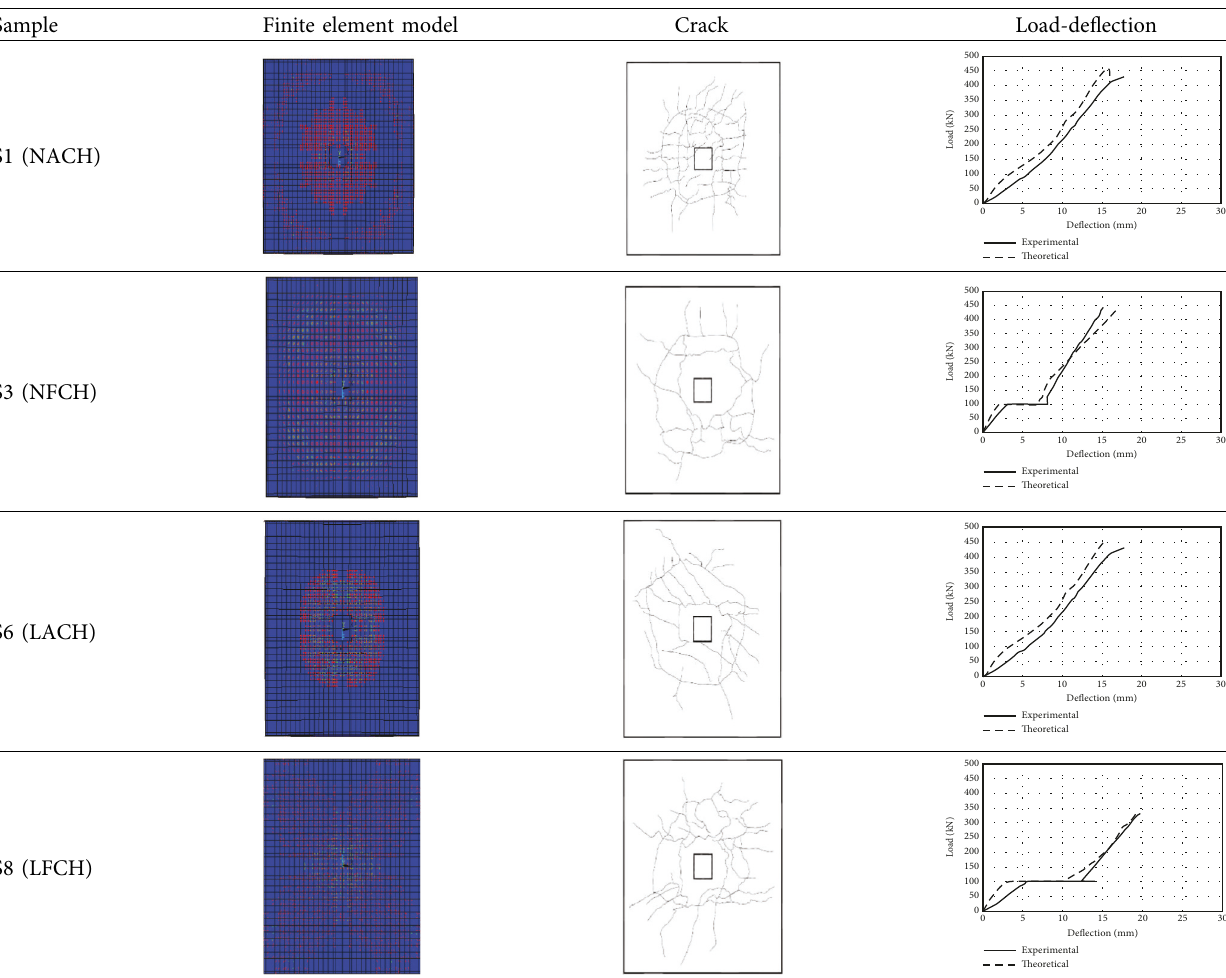
normal-weight concrete, L